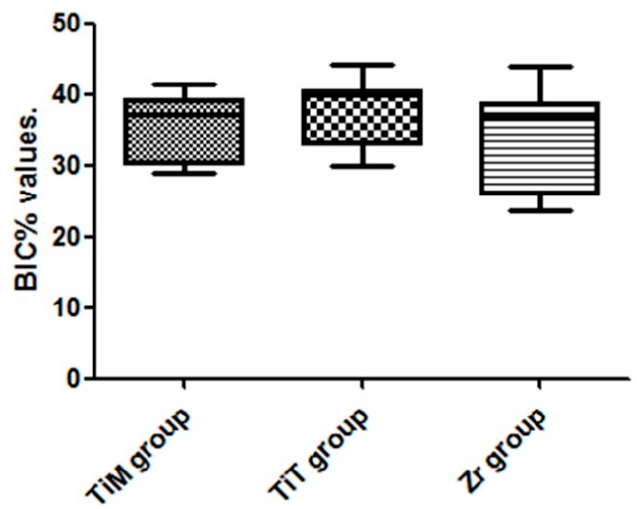
Figure 10. Box-Plot graph of the BIC% values of both groups.